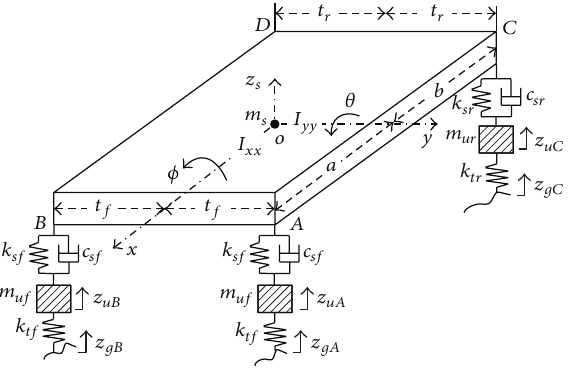
Figure 1: A 7-DOF vehicle model.